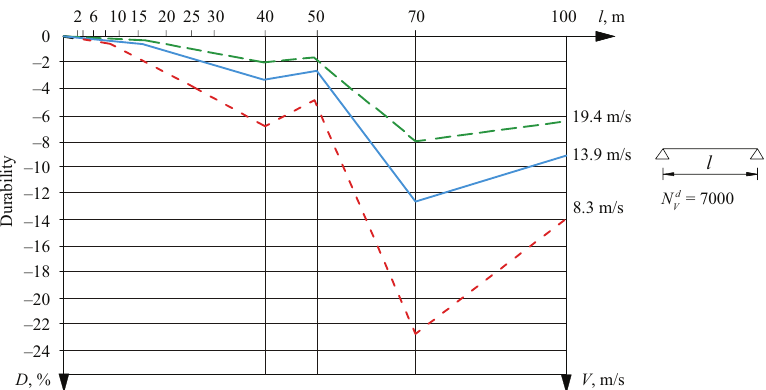
Figure 14. Influence of accounting for the overtaking of vehicles on the obtained strength (durability) of simply supported main girders of a two- lane bridge in the case of traffic volume per day N d V = 7000 depending on vehicles speed v